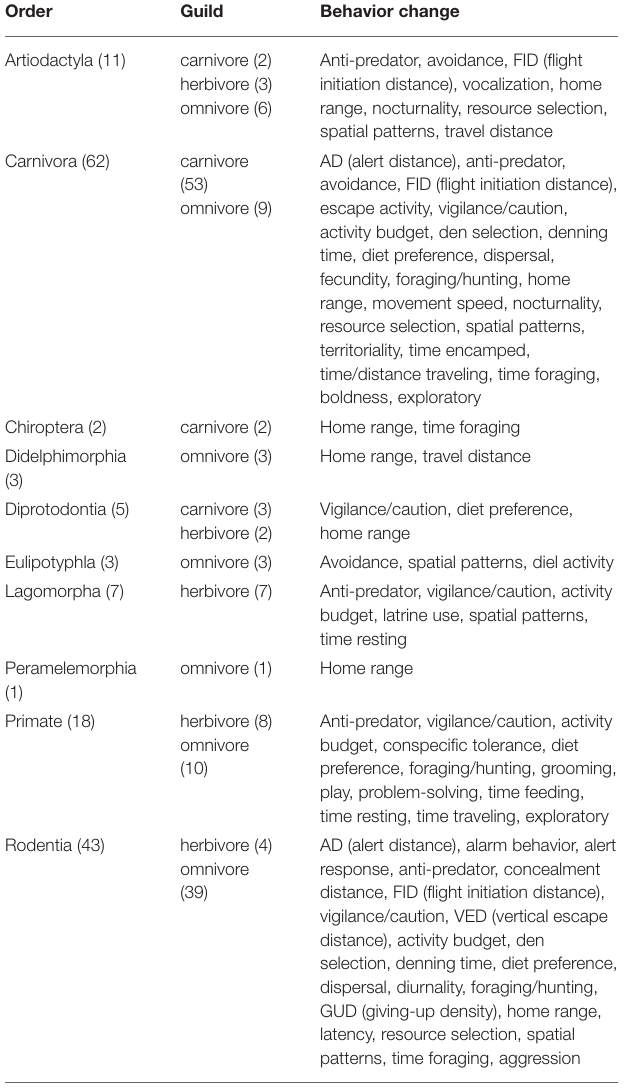
TABLE 2 | Behavior changes found in urban mammals grouped by order and